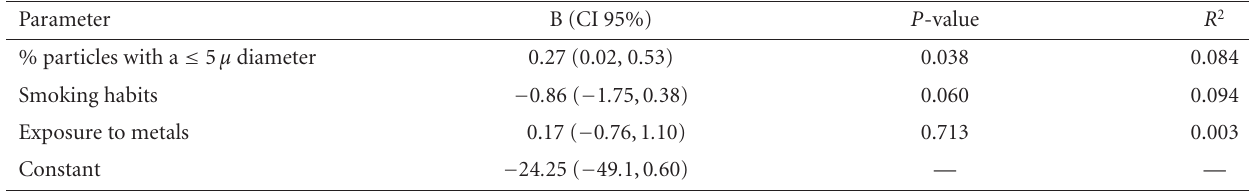
Table 4: Linear regression model for MMP-9 based on exposure, smoking habits, and proportion of particles ≤ 5 μ in diameter [total R 2 = 0 . 181, N =